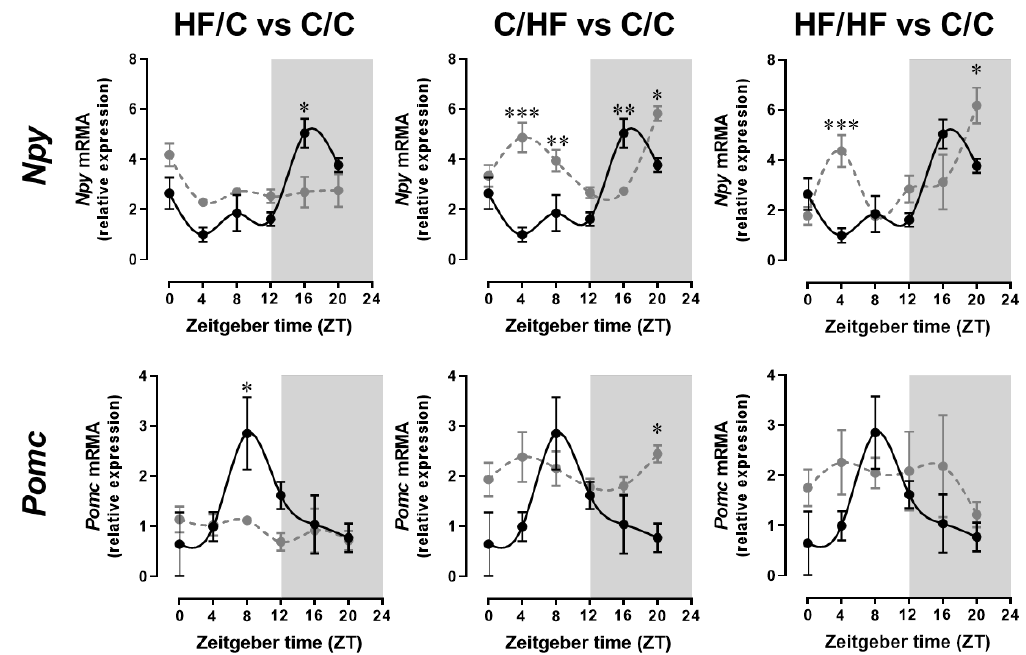
Figure 3. Maternal obesity and postweaning HF diet consumption alters rhythmic pattern of appetite gene expression in the arcuate nucleus (ARC). Transcripts of the genes that regulate food intake Npy and Pomc in the ARC were analysed by real-time PCR. Tissues were harvested every 4 h from 15-week-old male o ff spring from lean dams and on the control diet (C / C o ff spring, black lines), control-fed o ff spring from obese dams (HF / C o ff spring, grey lines), or with the HF-fed o ff spring from lean (C / HF group) or obese (HF / HF group) dams (grey lines). Values are displayed as relative expression (mean ± SEM) after normalisation to the housekeeping genes β -actin and Gapdh . ANOVA with Tukey post hoc test. * p < 0.05, ** p < 0.01, *** p < 0.001 between groups at each time